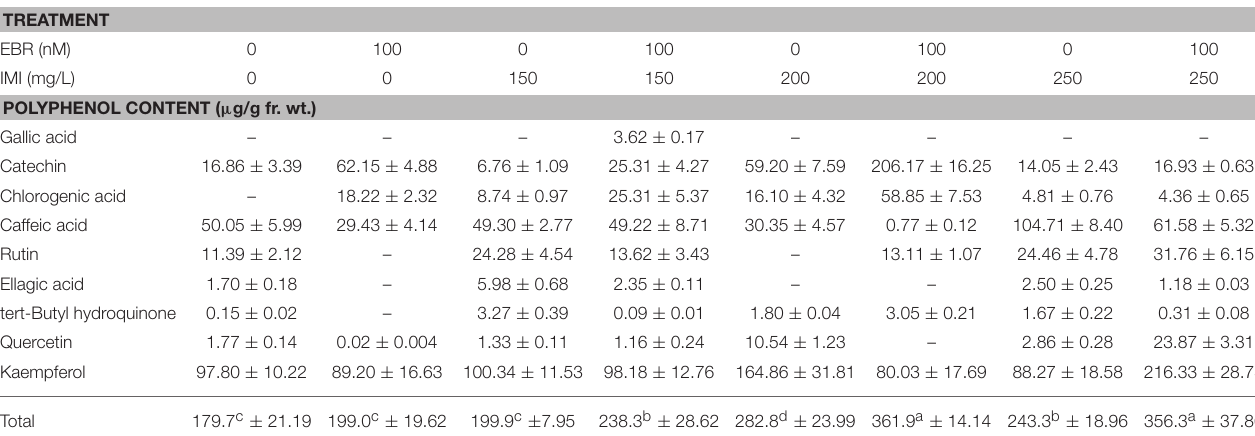
TABLE 3 | Effect of seed soaking with 24-epibrassinolide (EBR) on polyphenol contents in Brassica juncea seedlings grown under imidacloprid (IMI) toxicity. TREATMENT